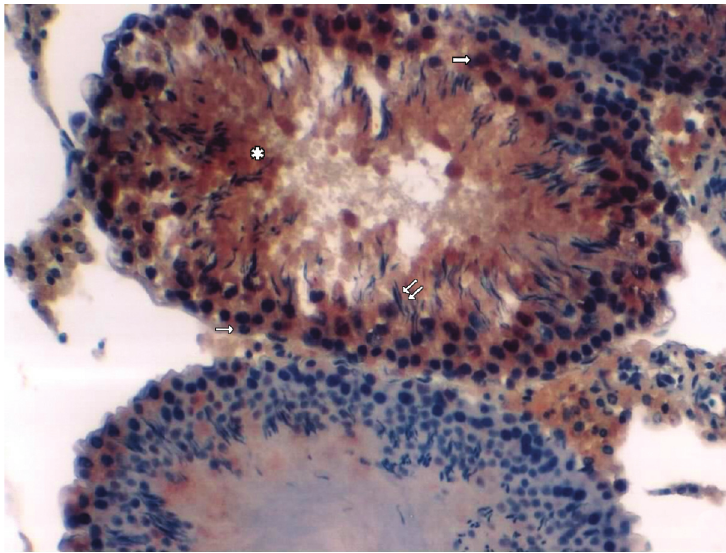
Figure 2. Abdominopelvic irradiation + melatonin (evening). Asterisk: Minimal degenerative changes in seminiferous tubules; thin horizontal arrow: negative-to- weak caspase-3 immunoreactivity in the spermatogonia; thick horizontal arrow: weak-to-moderate immunoreactivity in the primary spermatocytes; double oblique arrows: no immunoreactivity in spermatids (immunoperoxidase and hematoxylin staining,